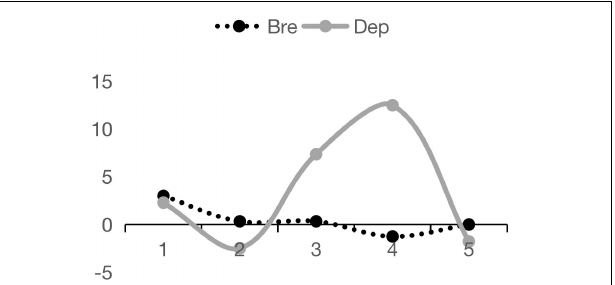
FIGURE 1 | Network embedding breadth, depth and firms’ innovation performances.